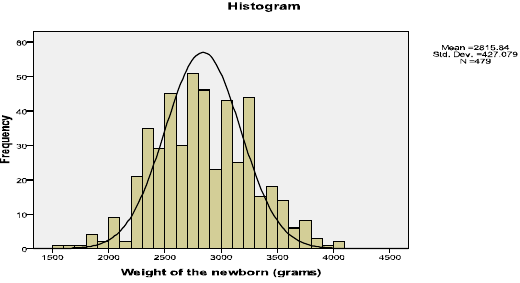
Table 1: relationship of BMI of mother with LBW Weight of the newborn (grams) p-value Normal